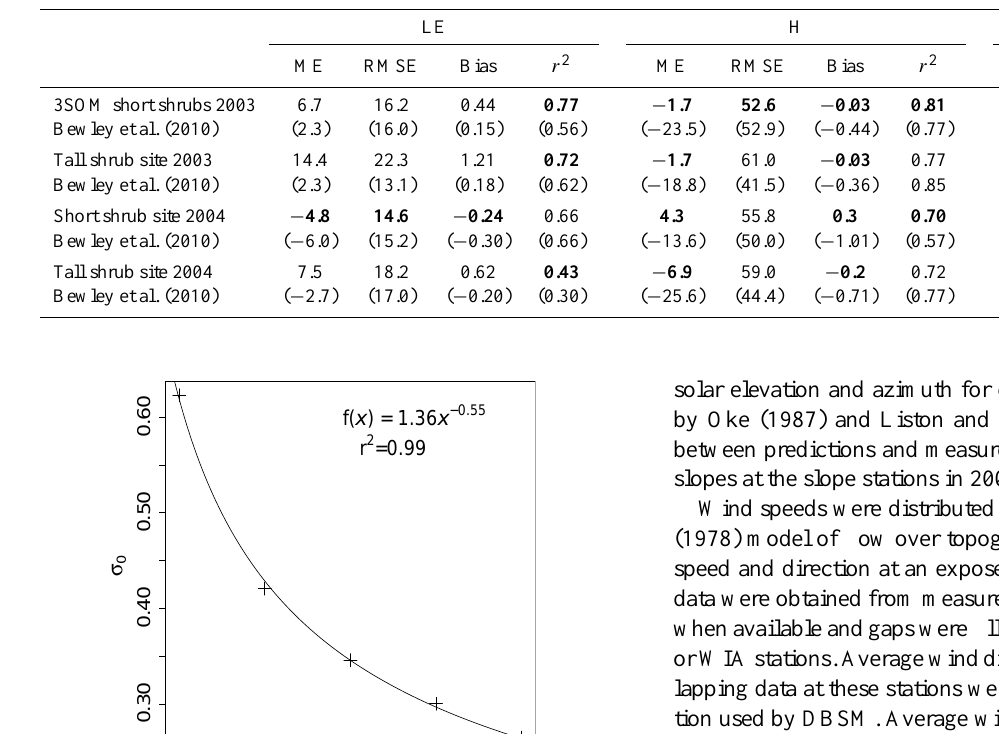
Table 2. 3SOM mean and root mean square errors, bias and correlation coefficient of sensible, latent and ground heat fluxes at the tall and short shrub sites in 2003 and 2004. The ME, RMSE and r 2 of the two-source model described in Bewley et al. (2010) are reproduced here in parentheses for convenience; the bias was calculated for this study. The bold numbers indicate higher quantitative values for 3SOM than the two-source model. ME and RMSE are in Wm − 2 .